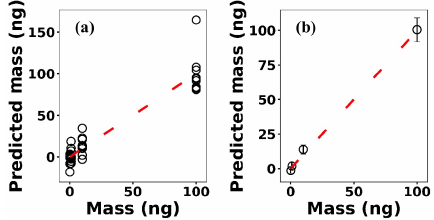
Figure 10. Ni 10ng spectrum (black line) and selected features by LASSO (red line).